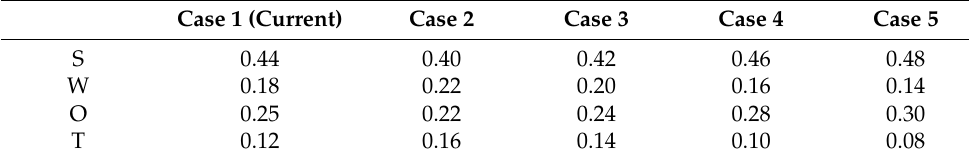
Table 4. SWOT factors weights according to different cases.